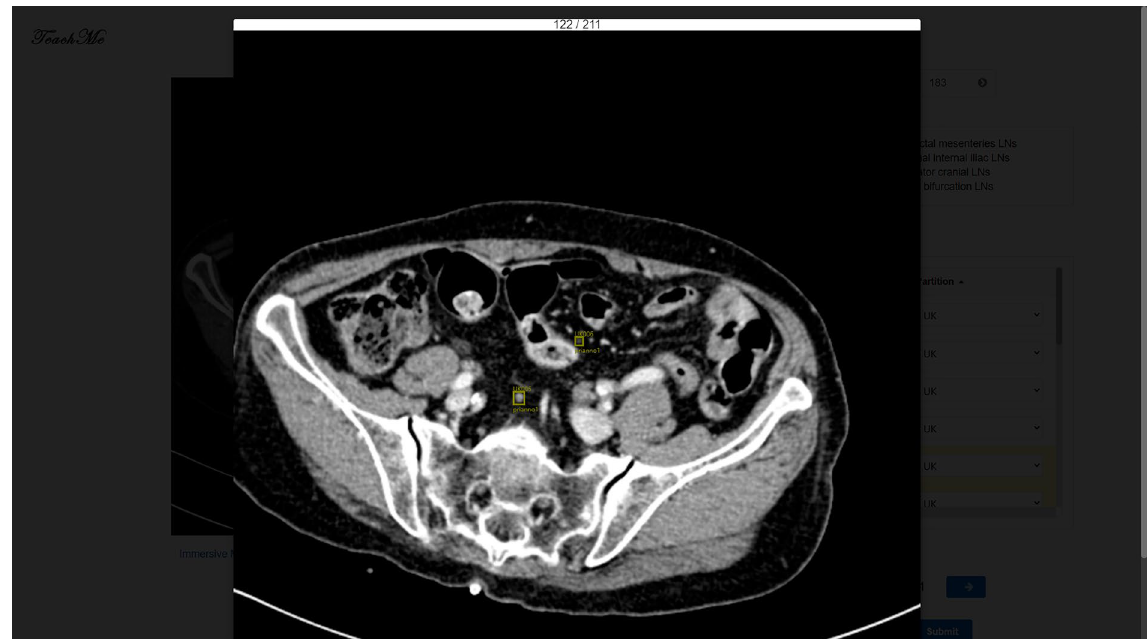
Figure 8. Immersive mode and editable.